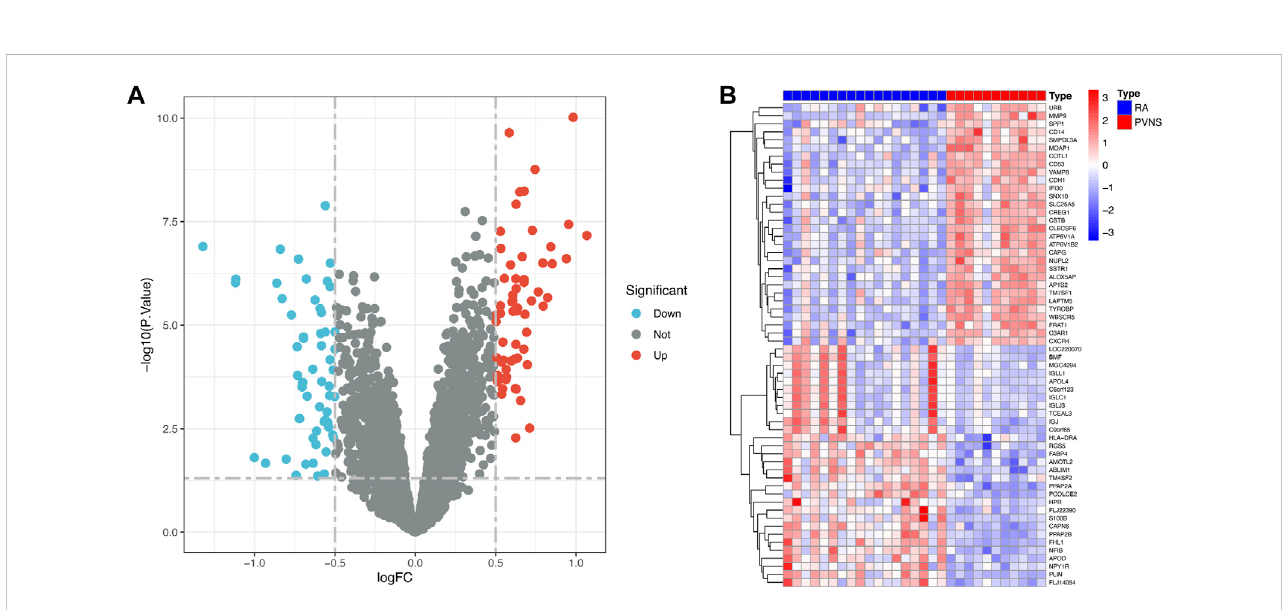
FIGURE 2 (A) The volcano map of GSE3698. (B) The heatmap of